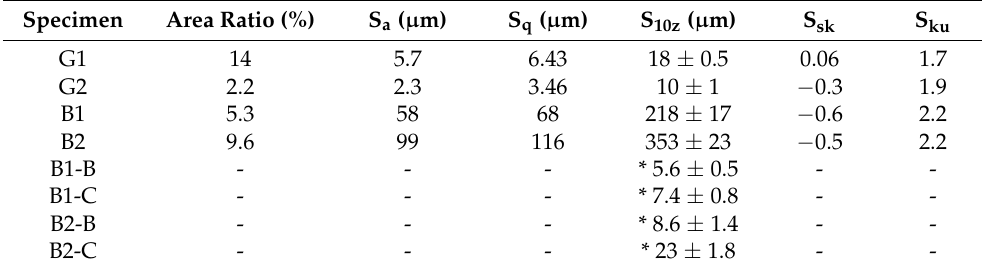
Table 2. Surface descriptors of the bare EB structures obtained by 3D metrology. S a : average surface roughness. S q : square root average surface roughness. S 10z : ten-point average height. S sk : skewness parameter. S ku : kurtosis parameter. Areas analyzed: G1 and G2 4.2 mm 2 . B1: (5.8 × 13) 75.4 mm 2 . Figure 4b,e,f. *: R 10z